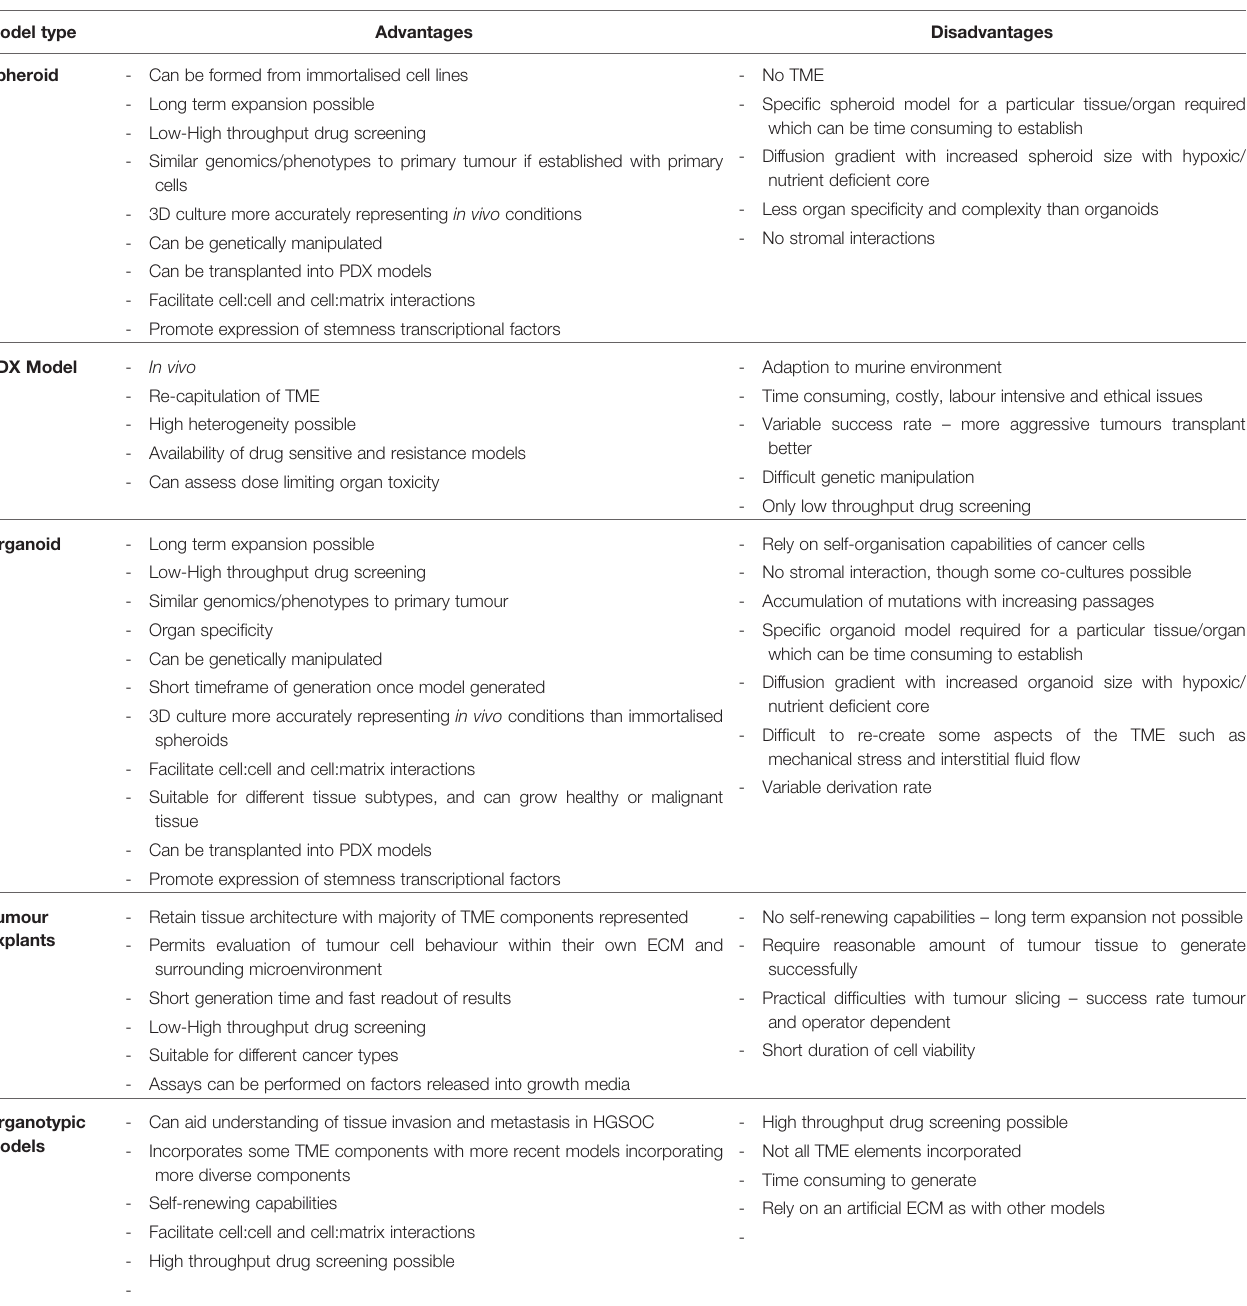
TABLE 1 | Advantages and disadvantages of different Ovarian Cancer 3D